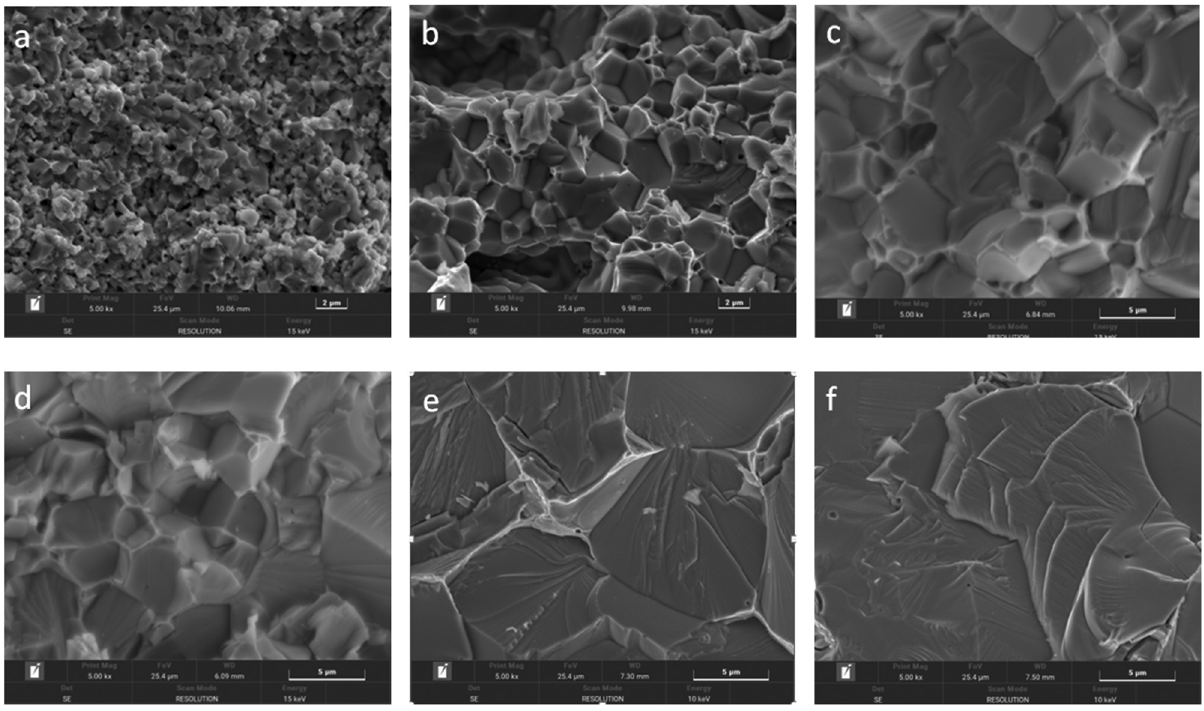
Figure 10: Fracture morphology of NbC – 10Ni cermets with di ff erent sintering temperatures: ( a ) 1,270°C, ( b ) 1,300°C, ( c ) 1,360°C, ( d ) 1,390°C, ( e ) 1,420°C, and ( f ) 1,450°C, and dwell time 15 min each.